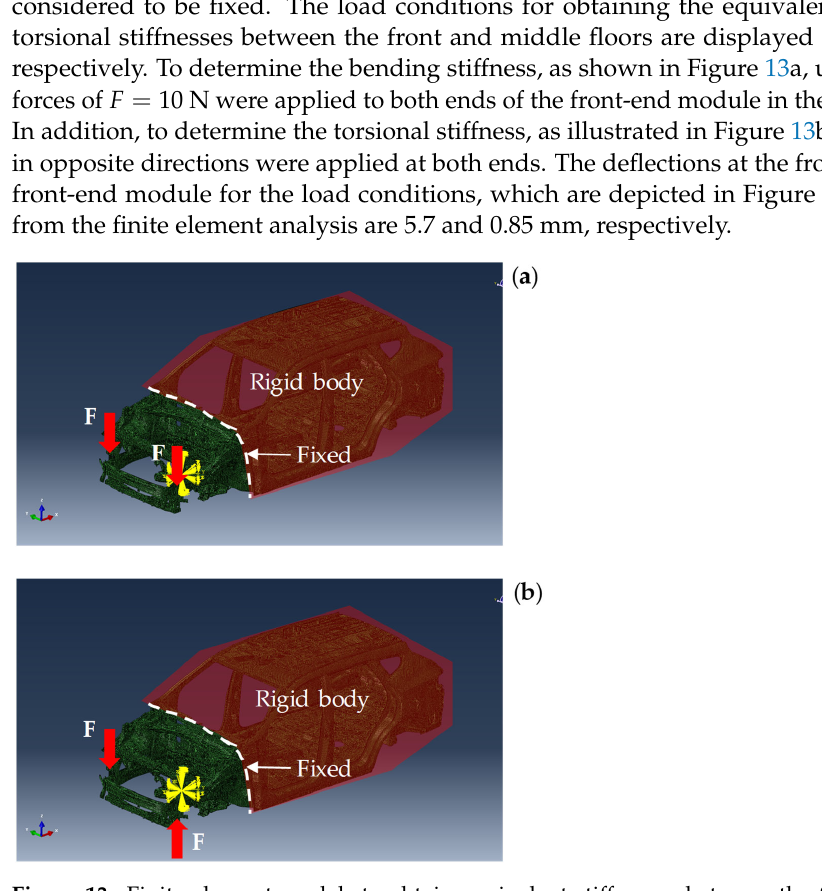
Figure 13. Finite element models to obtain equivalent stiffnesses between the front and middle body floors: ( a ) the load condition for the bending stiffness and ( b ) the load condition for the torsional stiffness.